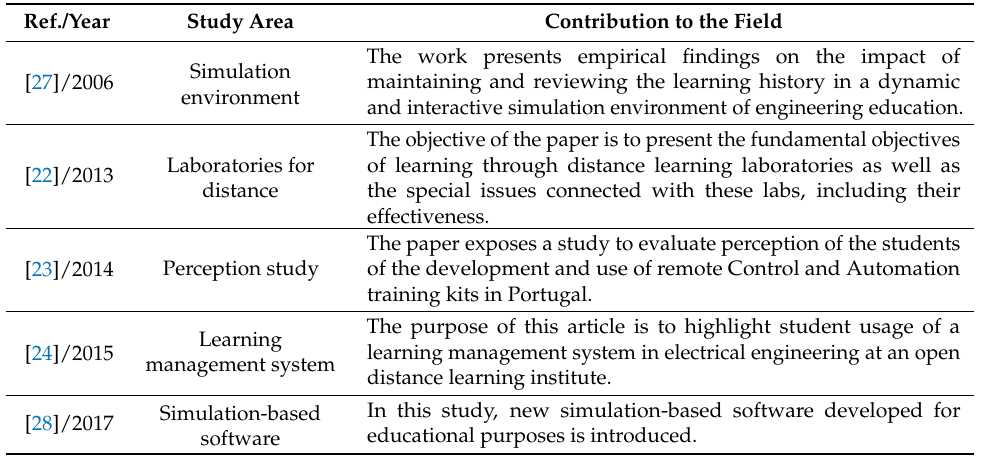
Table 1. Main investigation presented in the state of the art and their contribution to the field. Ref./Year The work presents empirical findings on the impact of maintaining and reviewing the learning history in a dynamic and interactive simulation environment of engineering education. The objective of the paper is to present the fundamental objectives of learning through distance learning laboratories as well as the special issues connected with these labs, including their effectiveness. The paper exposes a study to evaluate perception of the students of the development and use of remote Control and Automation training kits in Portugal. The purpose of this article is to highlight student usage of a learning management system in electrical engineering at an open distance learning institute. In this study, new simulation-based software developed for educational purposes is